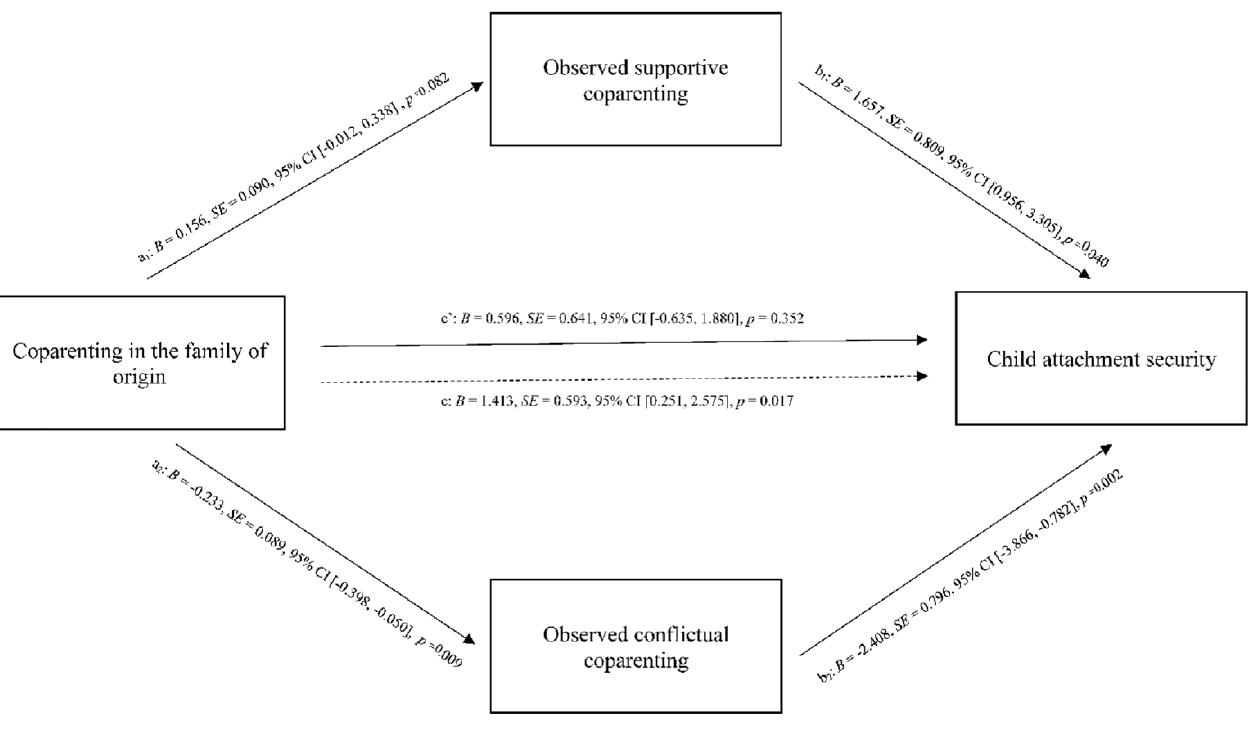
Figure 1. Parallel mediation of observed supportive and conflictual coparenting in the association between coparenting in the families of origin and child attachment security (N = 59).